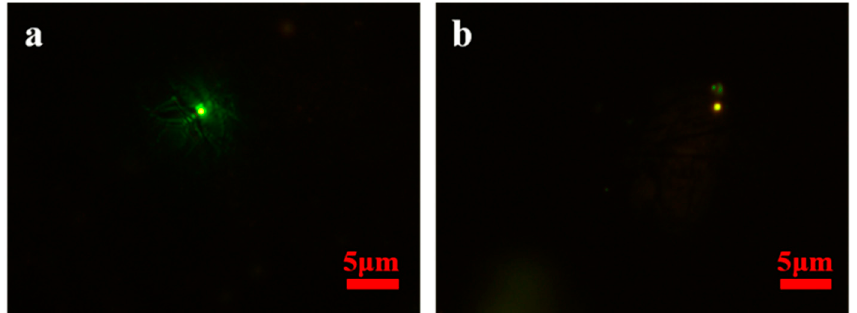
Figure 4. Representative photos of fluorescent microspheres tracked by different sampling methods in different sites. After aerosolization of fluorescent microspheres, fluorescent microspheres (green and yellow) were detected in ( a ) the filter membrane of an air sample using PM 10 samplers (100 L/min) under fluorescence microscopy and ( b ) the liquid of an air sample using biological aerosol samplers (100 L/min) under fluorescence microscopy.